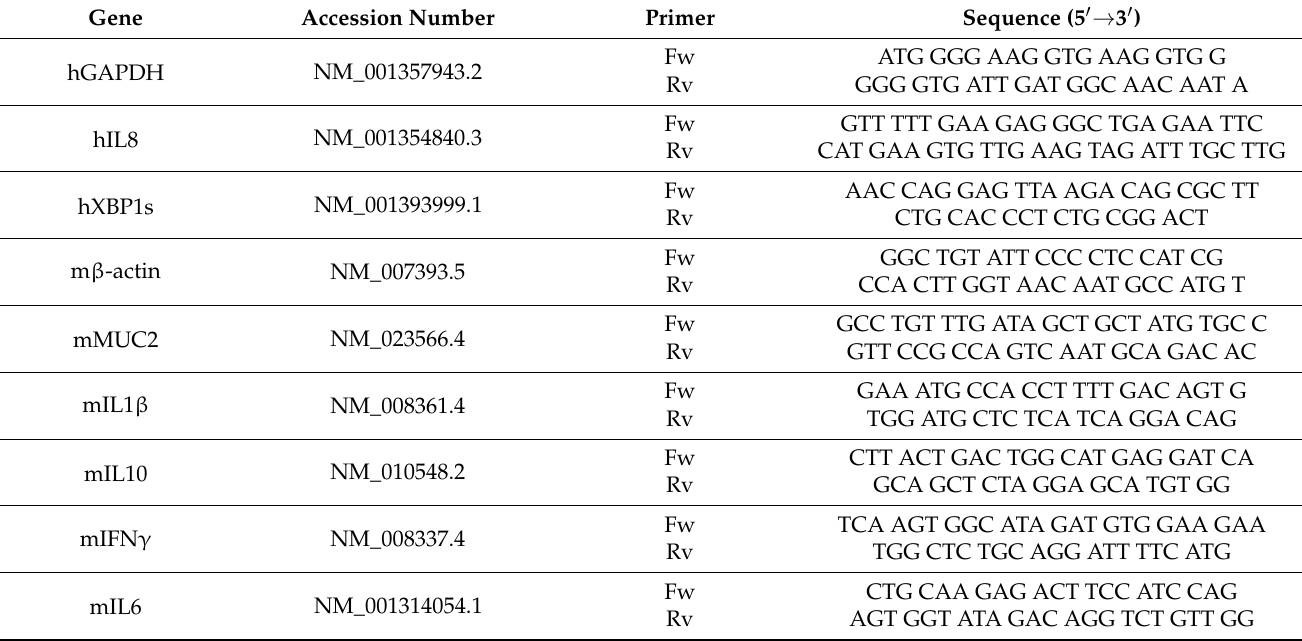
Table 1. Real-time PCR primer sequences for human and